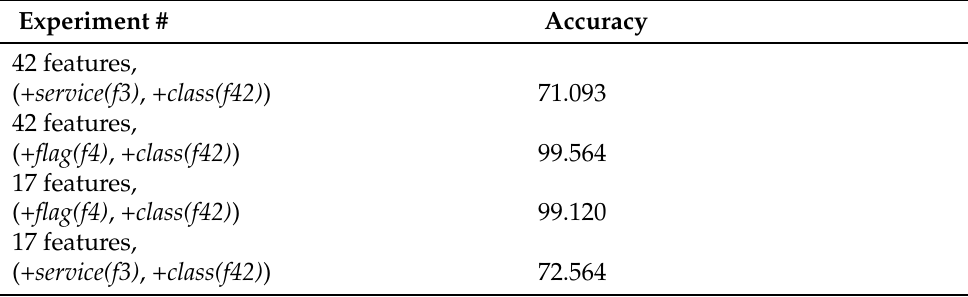
Table 2. Accuracy to the number of